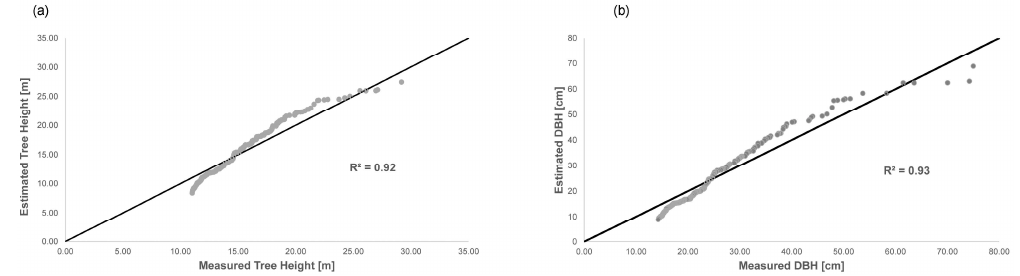
Figure 6. ( a ) Measured H compared to estimated H, derived from the LiDAR data; ( b ) Measured DBH compared to estimated DBH, obtained from the local height-diameter relationship.